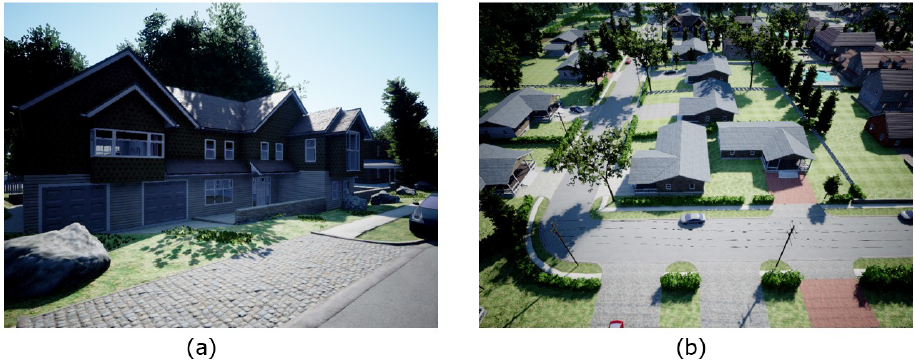
Figure 13. Picture of the two benchmark area of interest ( a ) and area of interest ( b ) obtained from